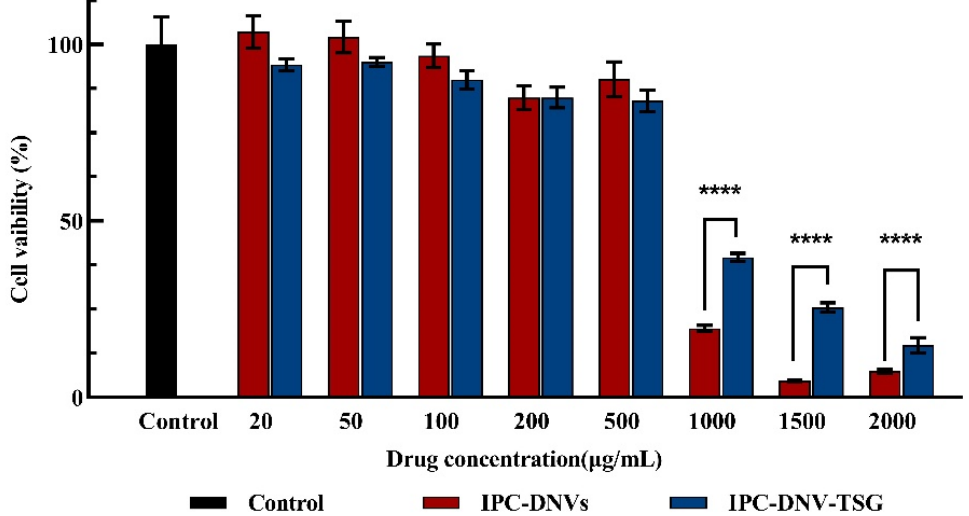
Figure 5. Viability of TR146 cells treated with different concentrations of IPC-DNVs and IPC-DNV- TSG at 37 °C for 4 h ( n = 6). **** p < 0.0001.